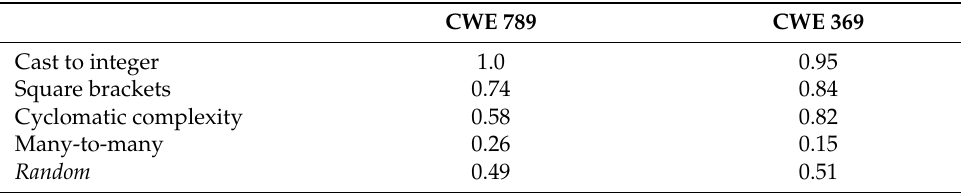
Table 1. Conceptual sensitivity of the models to different emerging concepts.